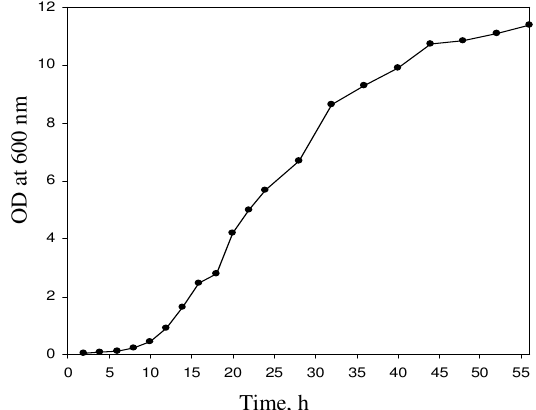
Figure 1. Growth profile of Lactobacillus plantarum MTCC 1407 in the seed medium (g L -1 ): beef extract- 10.0, glucose - 20.0, yeast extract - 5.0, peptone - 10.0, Na triammonium citrate - 2.0, MgSO